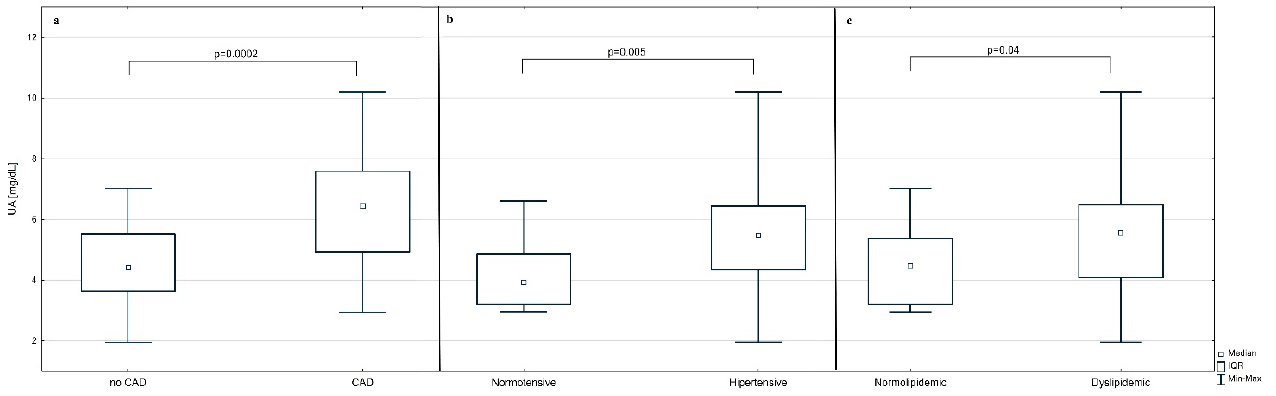
Figure 1. The concentrations of the uric acid in participants with and without analyzed comorbidities. ( a ) Patients with coronary artery disease (CAD) vs. patients without CAD (no CAD). ( b ) Hypertensive patients vs. normotensive patients. ( c ) Dyslipidemic patients vs. normolipidemic patients.